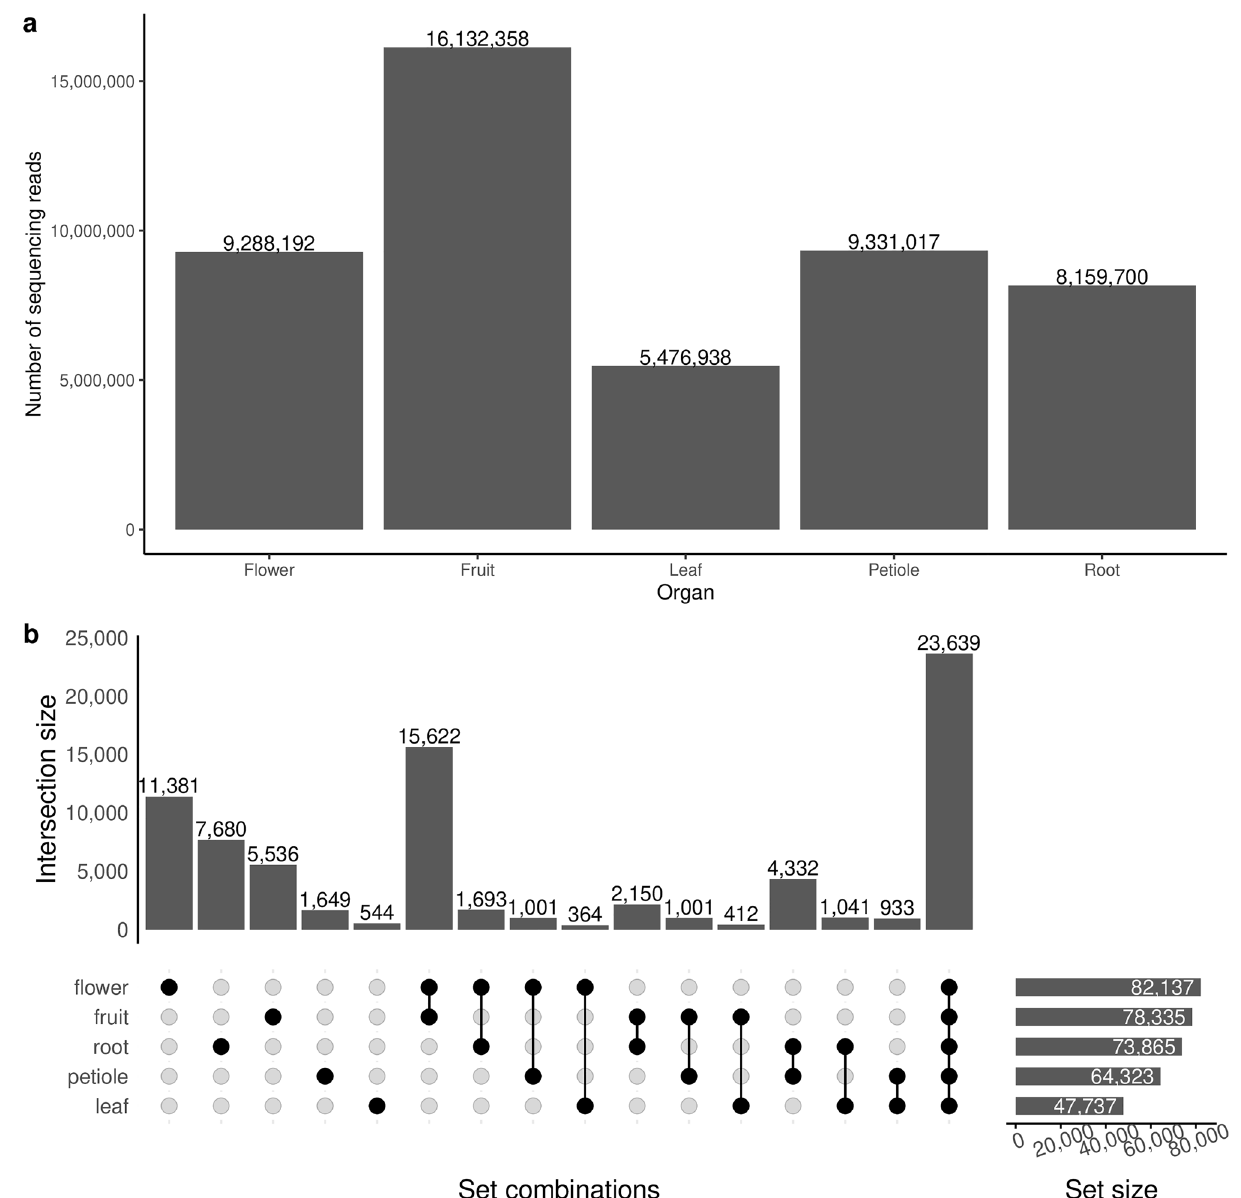
Figure 3. Data distribution across various organs of Conium maculatum L. ( a ) Illumina read set sizes: the bar shows the number of paired-end sequencing reads in each organ by averaging the number of reads among the two replicates. ( b ) Assembled transcripts: the bars indicate the numbers of transcripts expressed in each organ by averaging the expression value between replicates. The R packages ggplot (https:// ggplo t2. tidyv erse. org) and ComplexUpset (http:// doi. org/ 10. 5281/ zenodo. 37005 90) were used to draw these